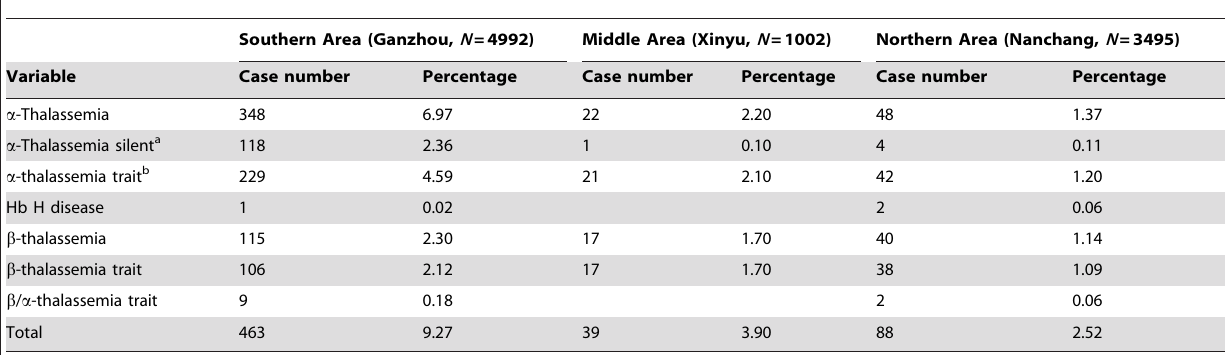
Table 1. Results of the survey of population prevalence of thalassemia among 9489 blood samples in the Jiangxi province.